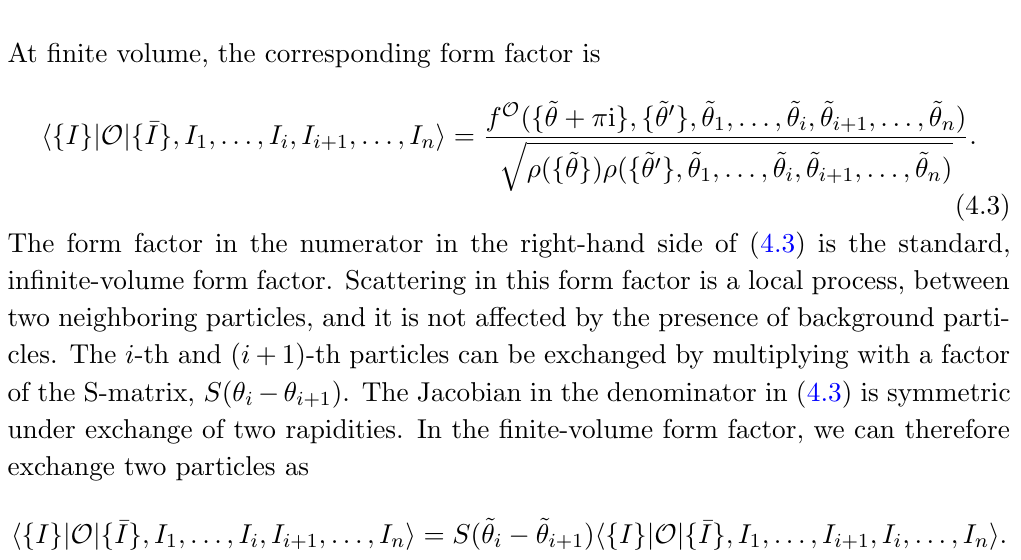
Figure 5. Scattering axiom in the presence of the